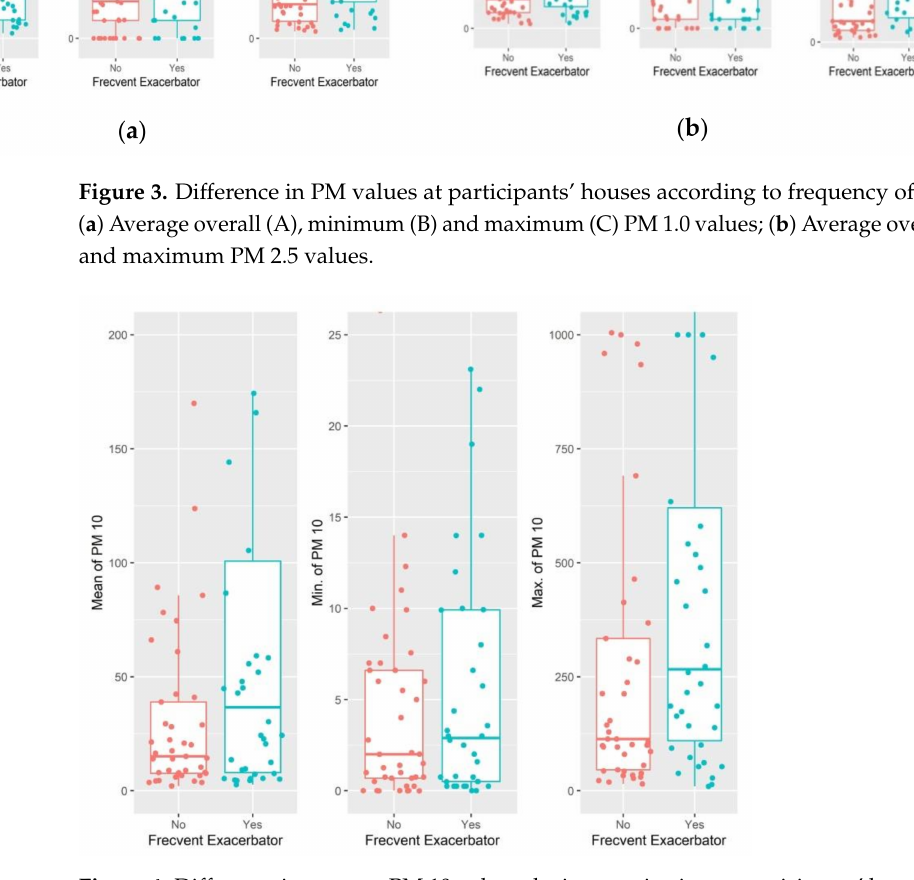
Figure 4. Difference in average PM 10 values during monitoring at participants’ homes according to frequency of